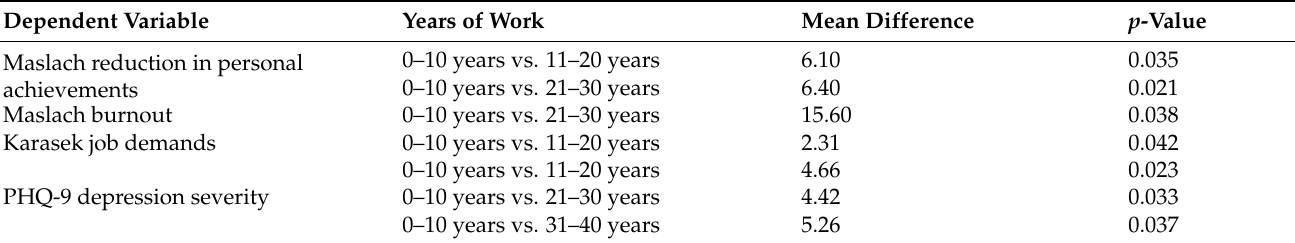
Table 9. Multiple comparisons of means between different groups of professional experience.